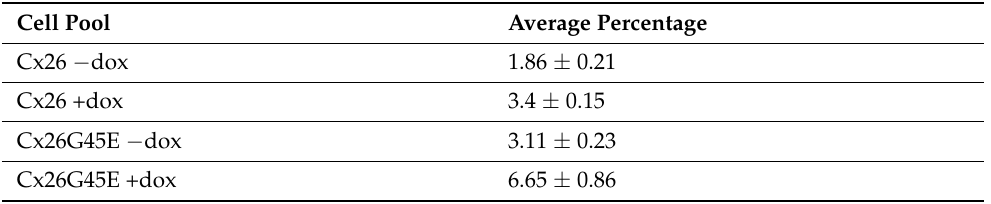
Table 2. Percentage of pyknotic nuclei in HaCaT cell pools overexpressing Cx26 or Cx26G45E, exposed (+dox) or not exposed to dox ( − dox) for 24